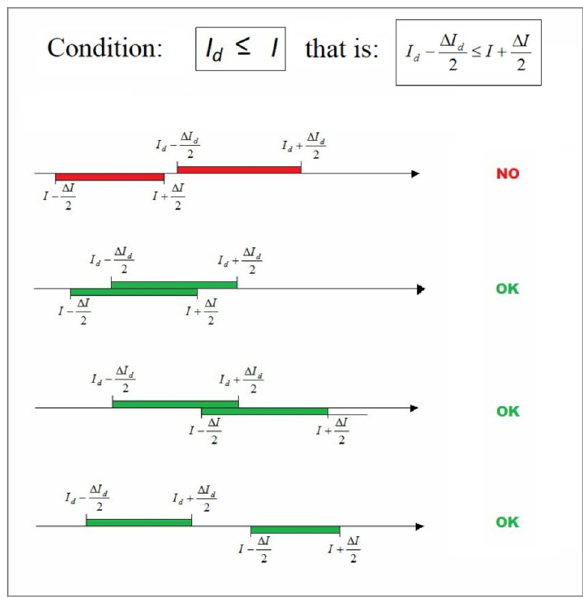
Figure 5. Validation of observation criteria.